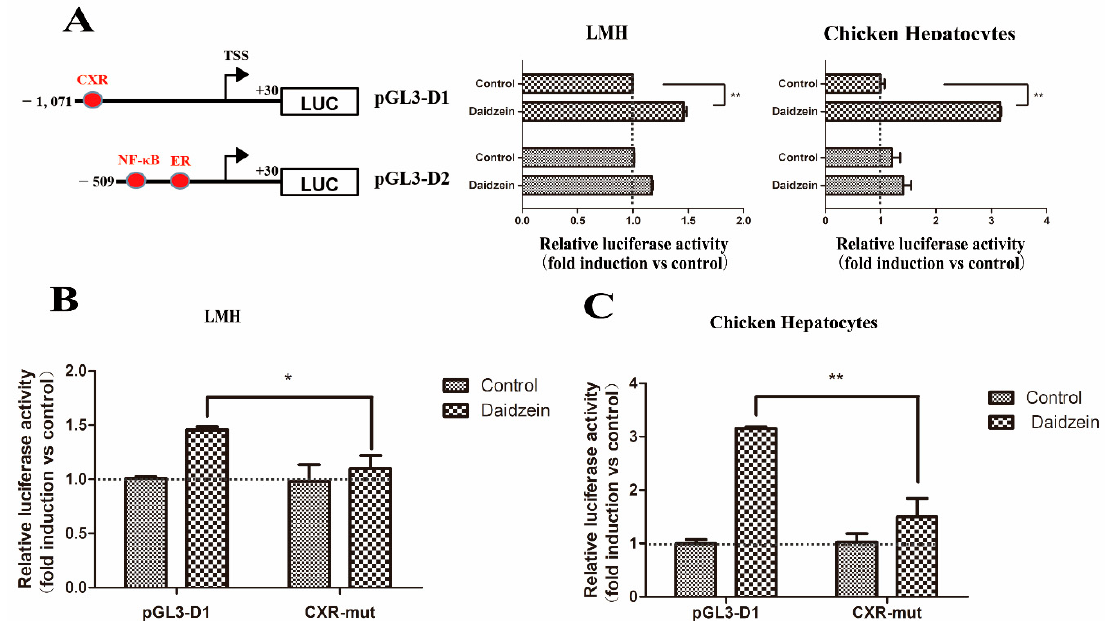
Figure 6. Regulation of chicken Abcg2 promoter activity by daidzein. ( A ) Isolation of the promoter elements responsible for mediating the stimulation of the Abcg2 gene promoter activity by daidzein. LMH cells and chicken hepatocytes were transfected with deletion constructs of the Abcg2 promoter. A schematic illustration of the Abcg2 gene promoter reporter plasmids used is shown in the left panel. A point mutation was introduced into the pGL3-D1 construct. ( B ) LMH cells and ( C ) chicken hepatocytes were transfected with each mutant. The fold increase in the luciferase activity by daidzein treatment of each construct is indicated. * represents p < 0.05 and ** represents p < 0.01.